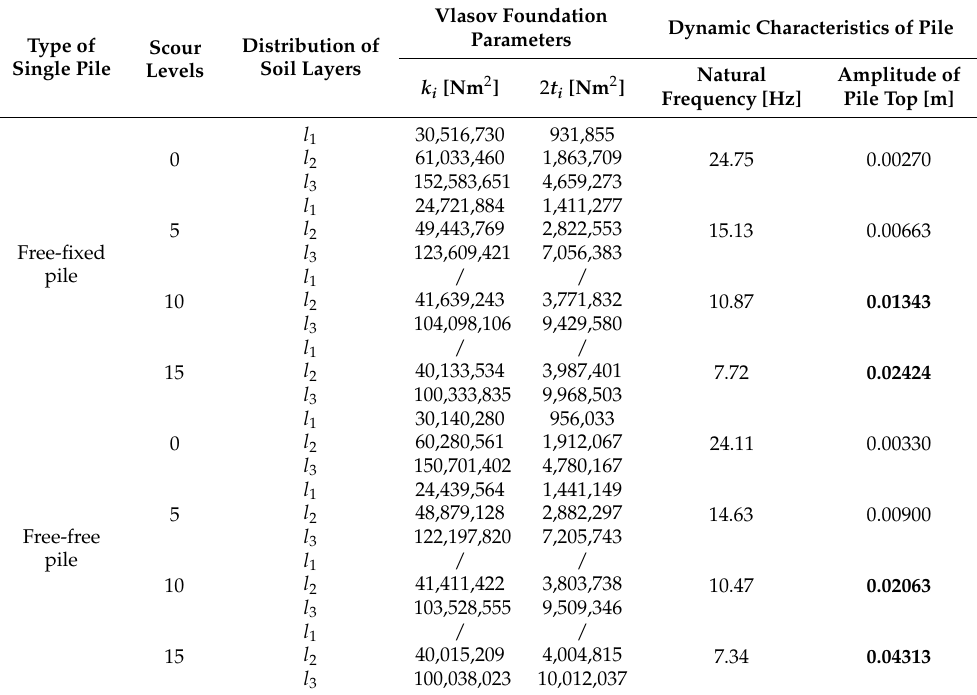
Table 2. Effect of the scour on Vlasov foundation parameters and dynamic characteristics of the single